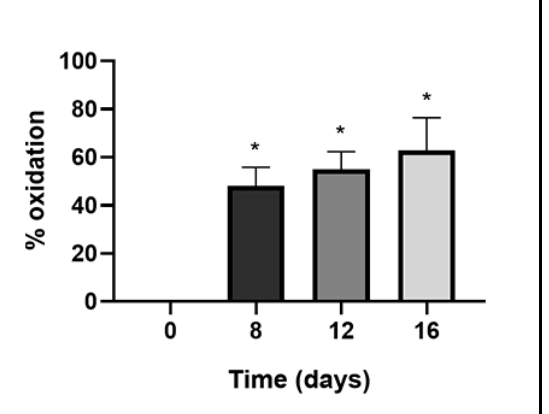
Figure 5. Influence of the incubation time on the oxidation of anthracene by FNTL. Anthracene (0.05 mg mL − 1 ) was exposed to partially purified FNTL (0.5 mg mL − 1 ) and 2 mM ABTS in 50 mM sodium citrate buffer pH 5.0. Reactions were incubated for 8, 12 and 16 days at 40 ◦ C with shaking